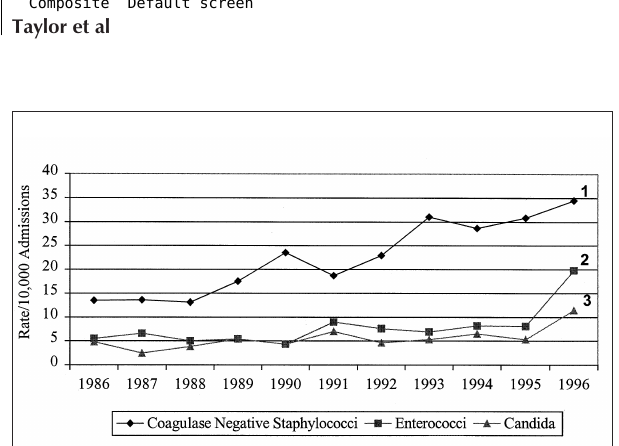
Figure 2) Case rate for selected microorganisms causing nosocomial blood stream infections, University of Alberta Hospital, 1986 to 1996. 1 Risk ratio (RR) 2.56(1.52 to 4.31) compared with 1986; 2 RR 2.44 (1.45 to 4.11 compared with 1995); 3 RR 2.16 (1.11 to 4.18 compared with